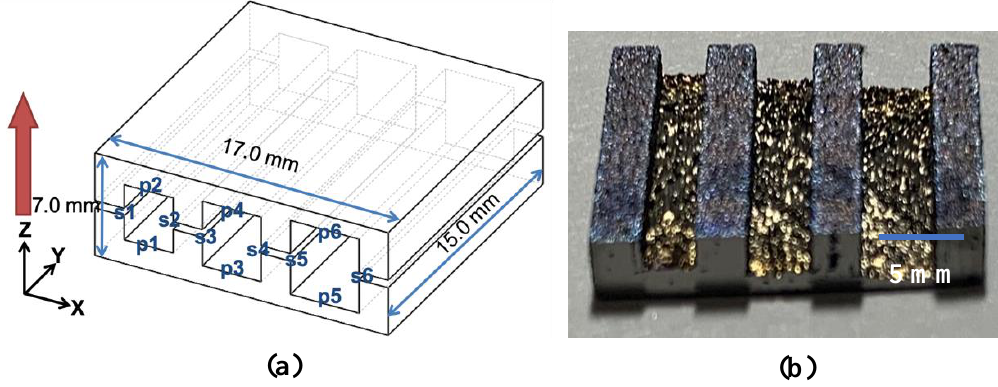
Figure 2. Specimen model with measuring information( a ) and cutting surface( b ) in this study.